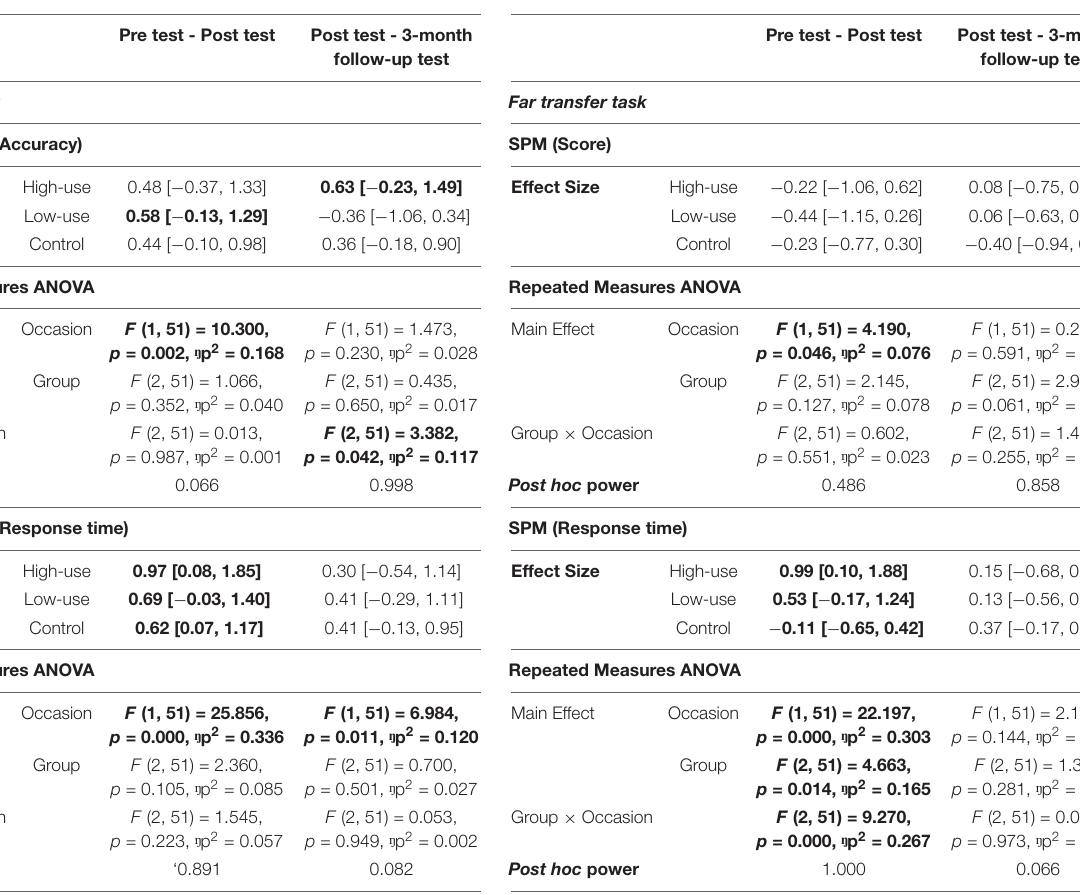
TABLE 14 | ANOVA analysis and effect sizes of far transfer SPM task in Experiment 2.